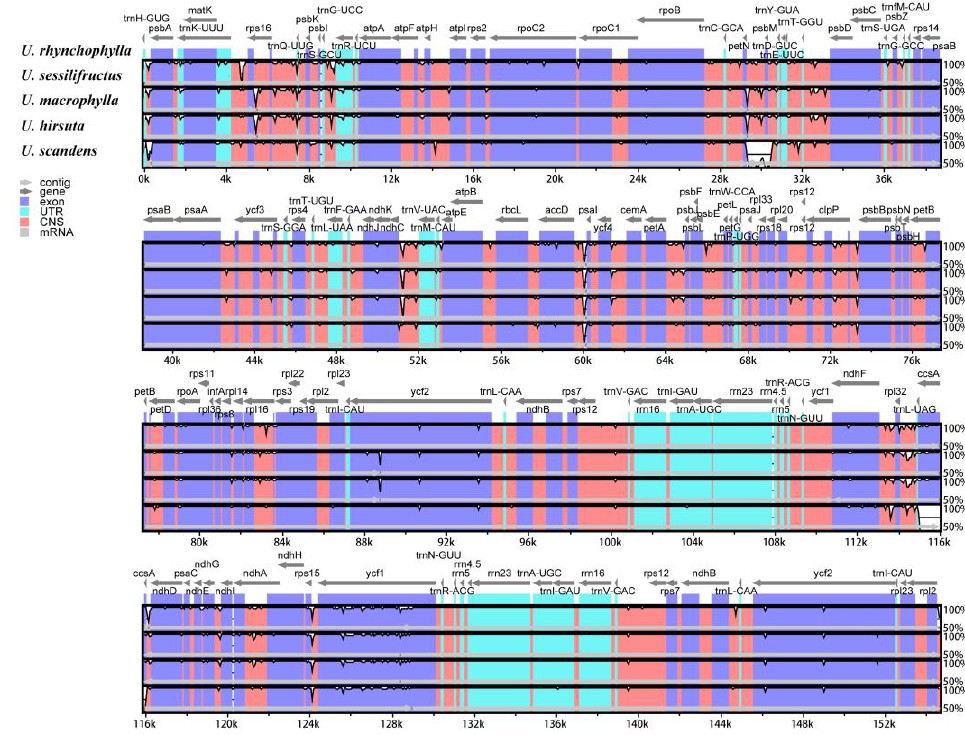
Figure 12. Sequence identity plots among five Uncaria species. The x-axis represents aligned base sequences, and the y-axis represents percent pairwise identity within 50 – 100%. (Coding regions were shown in blue, and non-coding regions were shown in pink. The locations and directions of each gene were indicated by gray arrows above the alignment. CNS: conserved noncoding sequences; UTR: untranslated region.).